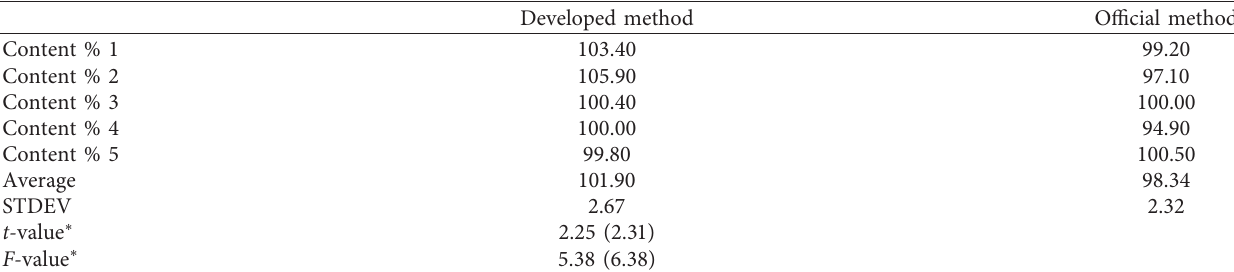
Table 6: Statistical comparison between the developed method and the official